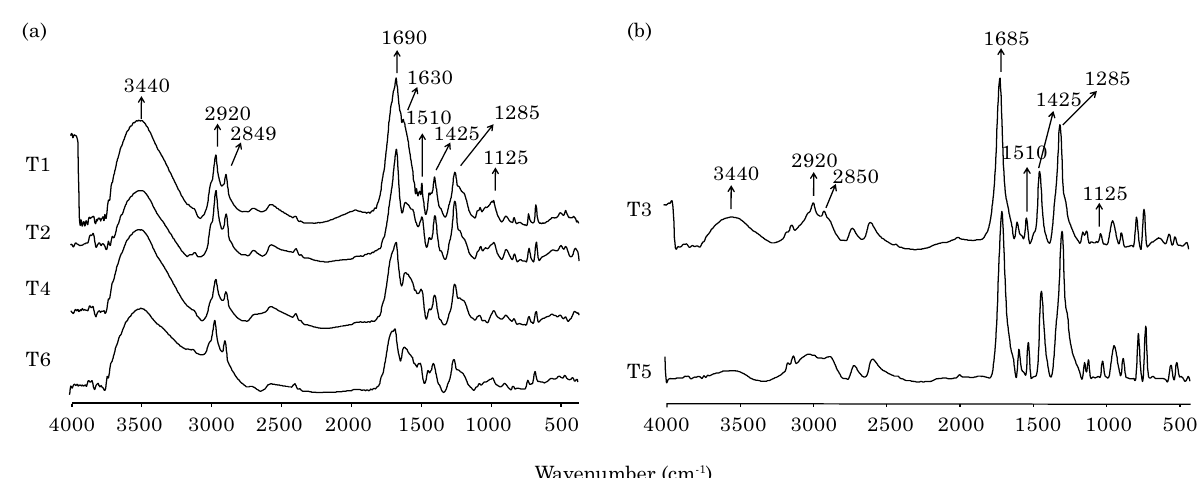
Figure 2. Ftir spectra of the humic acid fraction of the organic matter in the 0.00-0.03 m layer of a constructed soil under cover crops, a bare constructed soil and a natural soil in a coal mining area. (a) ga: hemarthria (t1), Paspalum (t2), brizantha (t4) and natural soil (t6). (b) gb: Cynodon (t3) and bare soil